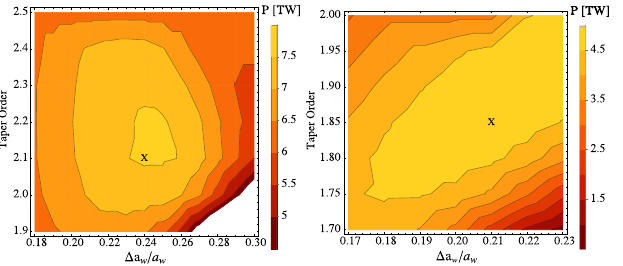
FIG. 4. Maximum radiation power as a function of taper order d and taper amplitude Δ a w =a w for time independent (left) and time dependent (right) simulations for the case of 1.5 MeV input energy spread.